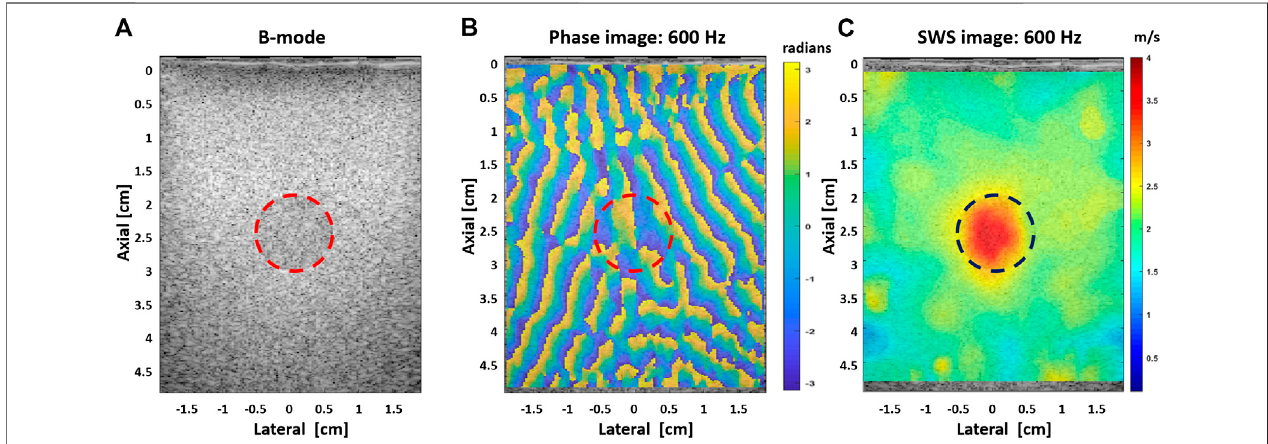
FIGURE4|(A) B-modeimageoftheCIRSbreastphantomshowingacircularinclusionthatrepresentsastifferlesion. (B) Extractedphasemappatternat600 Hz; the random pattern indicates the different propagation directions of the shear waves generated with the vibration sources. (C) SWS map using the RSWE estimator at 600 Hz. The red and blue dashed circles in (B,C) , respectively, illustrate the location of the inclusion.